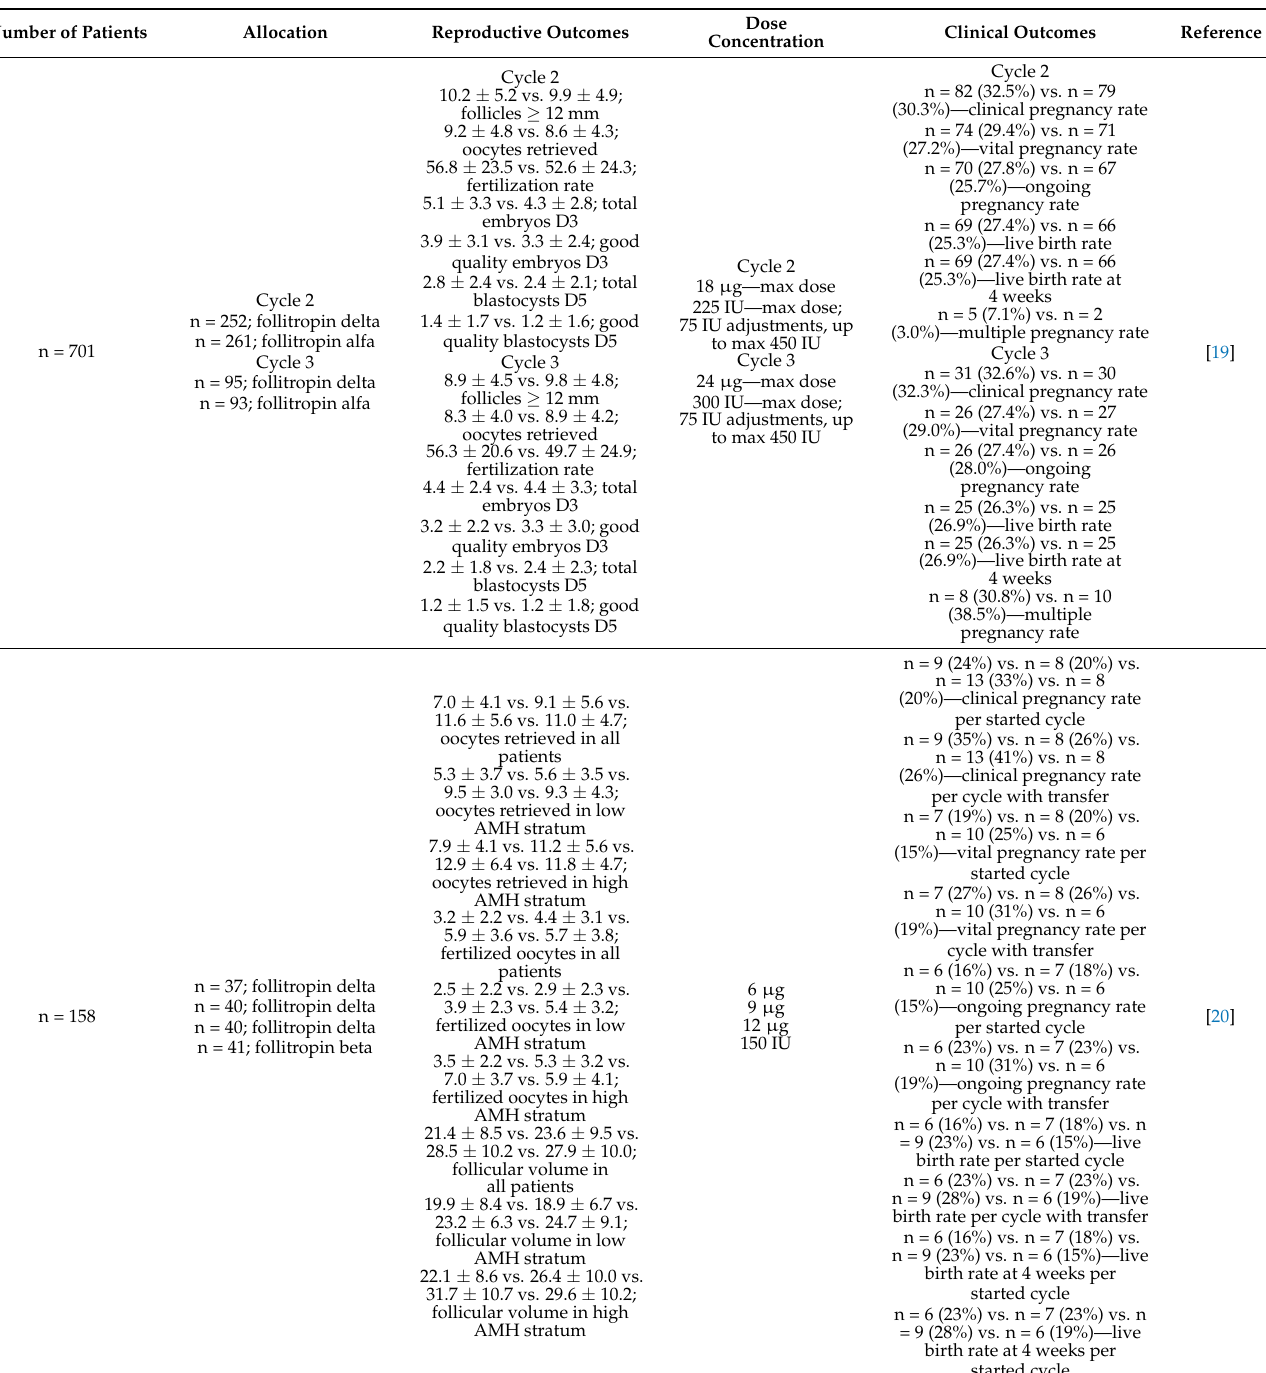
Table 1. Overview of the reproductive and clinical